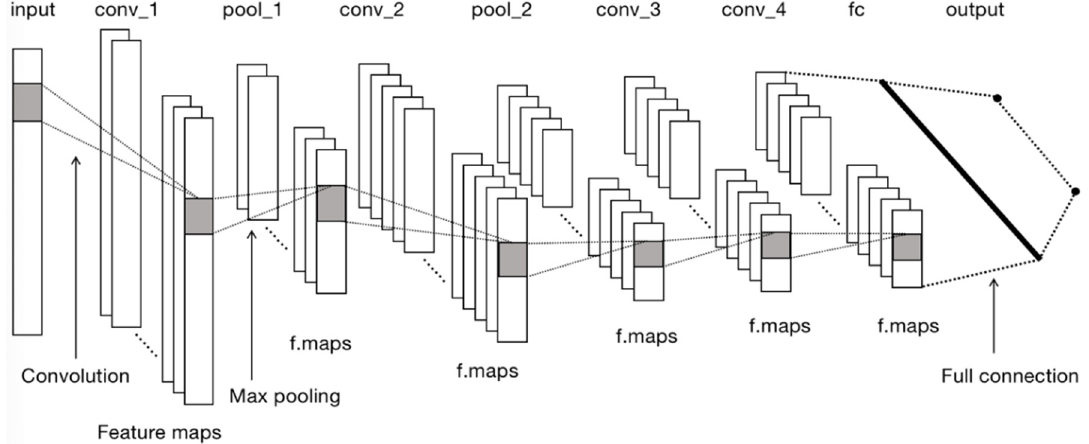
Figure 3. Frame structure for the 1D ‐ Net model.